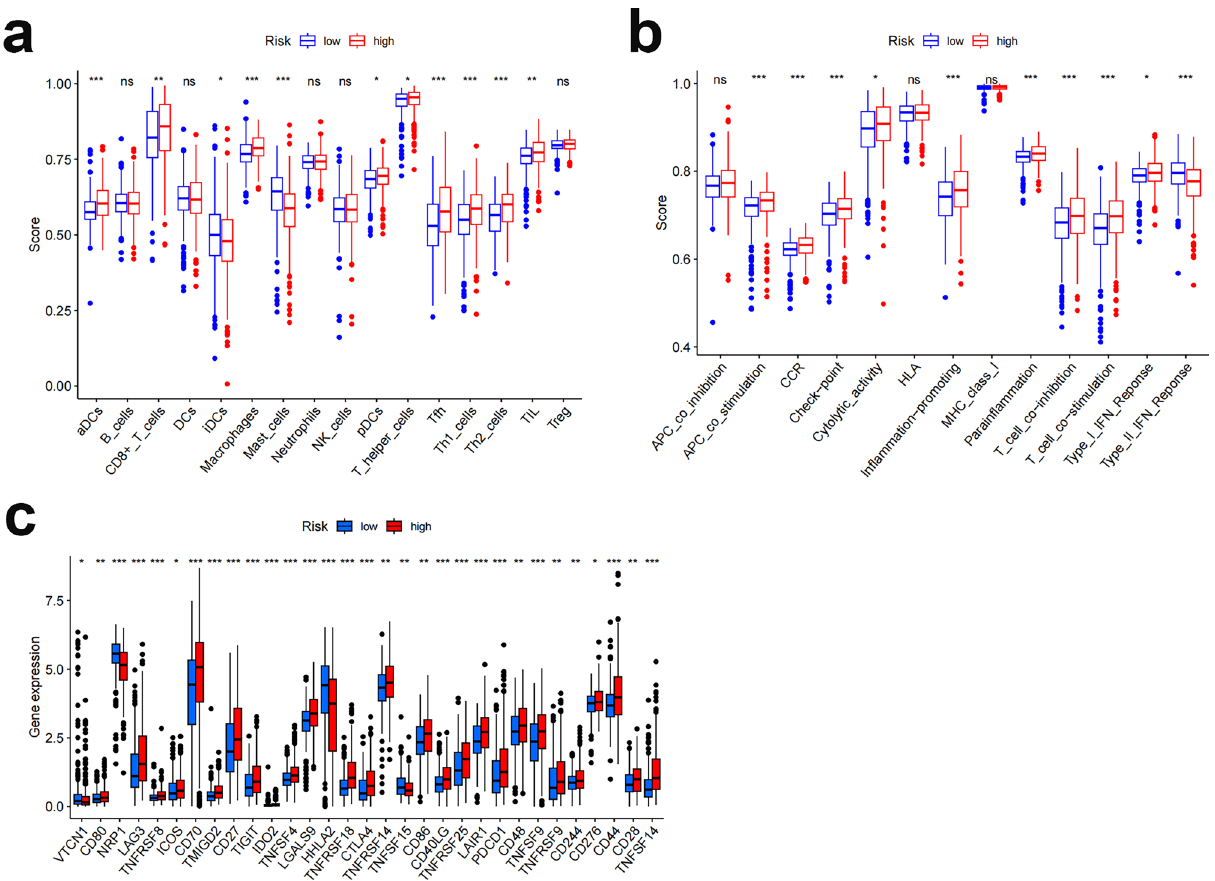
Figure 11. Immuno-infiltration analysis. Results of ssGSEA scoring. ( a ) Sixteen immune cell scores. ( b ) Thirteen immune-related function scores. ( c ) Expression of immune checkpoints in high- and low-risk populations. ssGSEA, single-sample gene set enrichment analysis; aDCs, activated dendritic cells; iDCs, immature dendritic cells; NKs, natural killer cells; pDCs, plasmacytoid dendritic cells; Tfh, T follicle helper cell; Th1, T helper factor type 1; Th2, T helper cell type 2; TIL, tumor-infiltrating lymphocyte; Treg, T-regulatory cell; APC, antigen-presenting cell; CCR, chemokine receptor; HLA, human leukocyte antigen; MHC, major histocompatibility complex; IFN, interferon. *p < 0.05; **p < 0.01; ***p < 0.001; ns, not